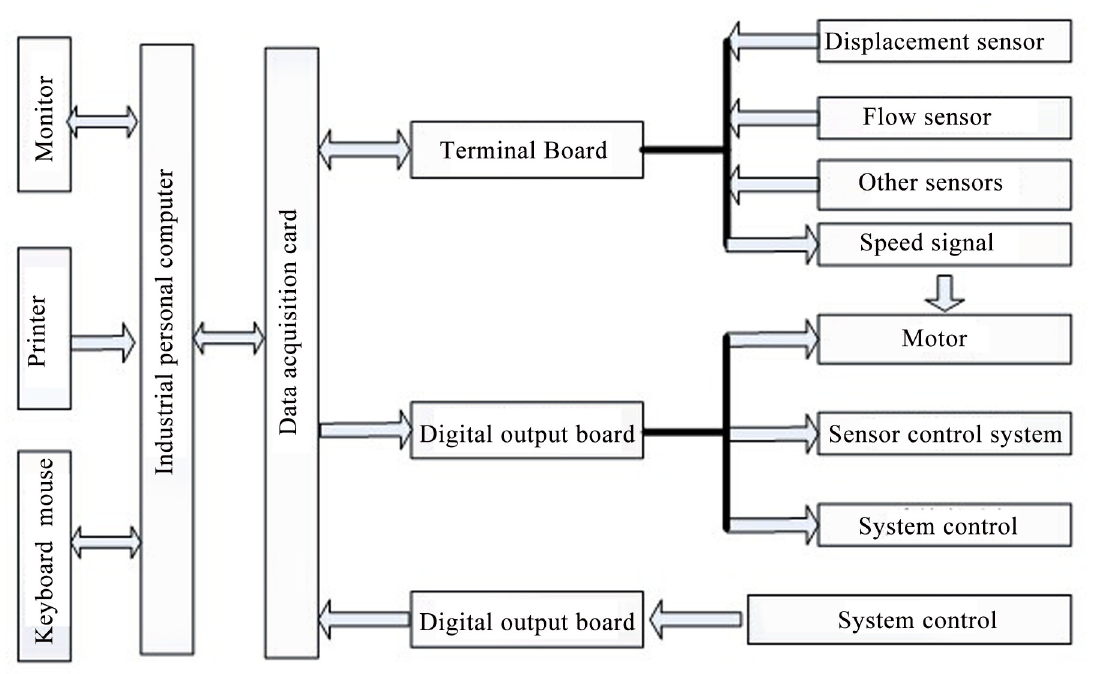
Fig 10. Data acquisition system schematic